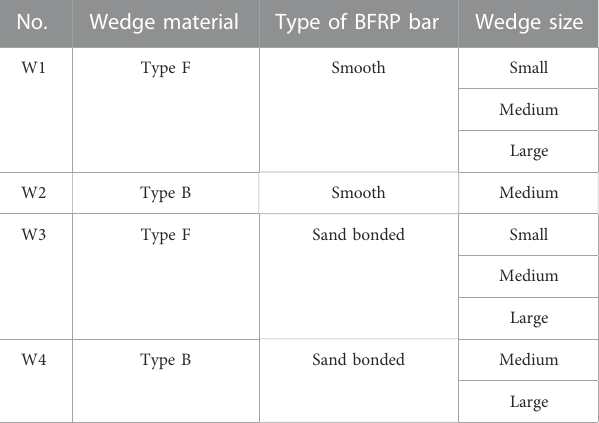
TABLE 2 Tensioning test design of the WMAS under static